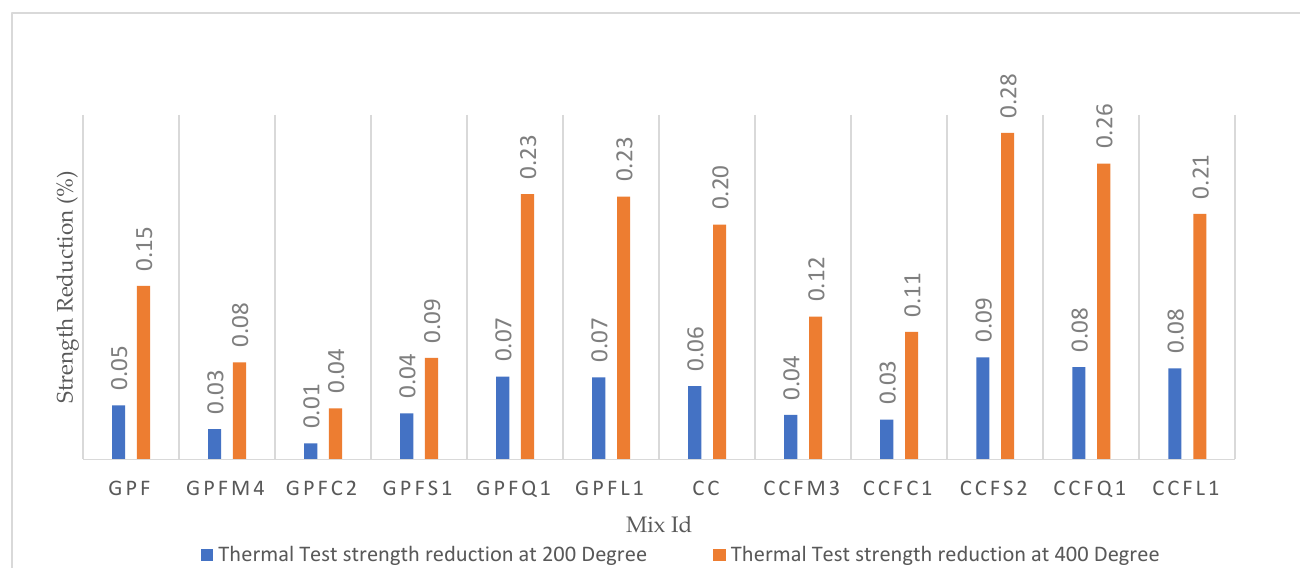
Figure 12. Thermal test results at 200 °C and 400 °C.